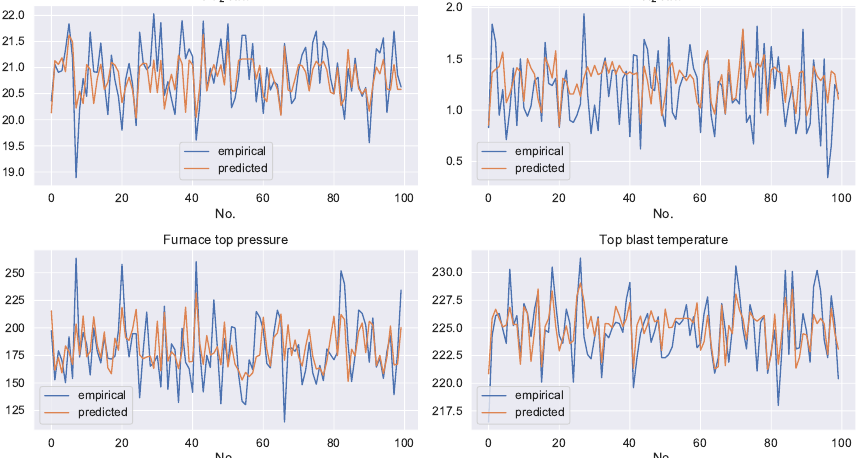
Figure 5. Regression results for the uncontrollable variables. The horizontal axis of each subplot indicates the numbers of the samples. The vertical axis indicates the value of each